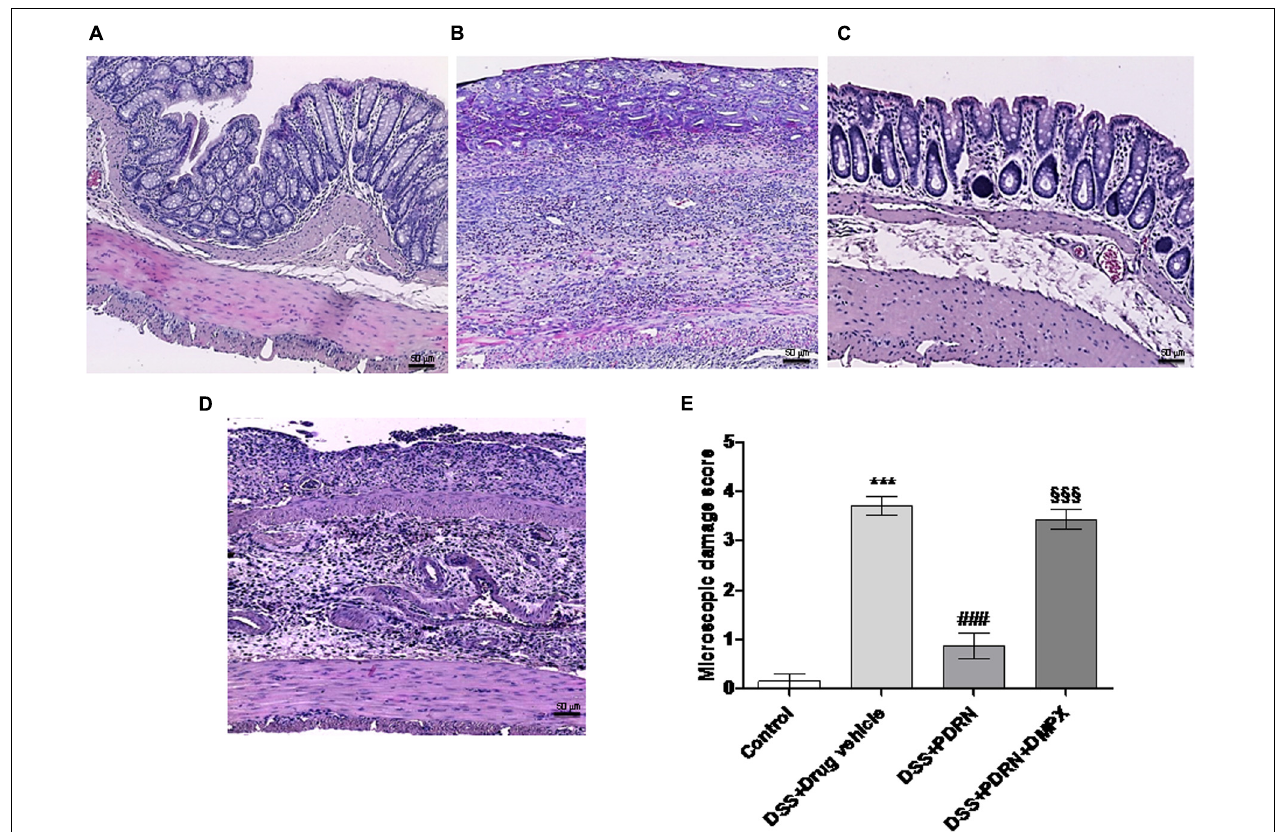
FIGURE 4 | Histological evaluations from DSS-treated animals. Representative H&E images (original magnification 10 × ) of tissues derived from control (A) , DSS + drug vehicle (B) , DSS + PDRN (C) , or DSS + PDRN + DMPX (D) treated animals are shown here. The graph in (E) represents the microscopic damage score values expressed as means and SEM derived from seven animals for each condition. ∗∗∗ p < 0.0001 vs control group; ### p < 0.0001 vs DSS + drug vehicle group; §§§ p < 0.0001 vs DSS + PDRN group. Scale bar 50 µ